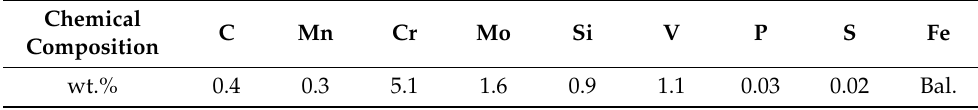
Table 2. The chemical composition of material H13